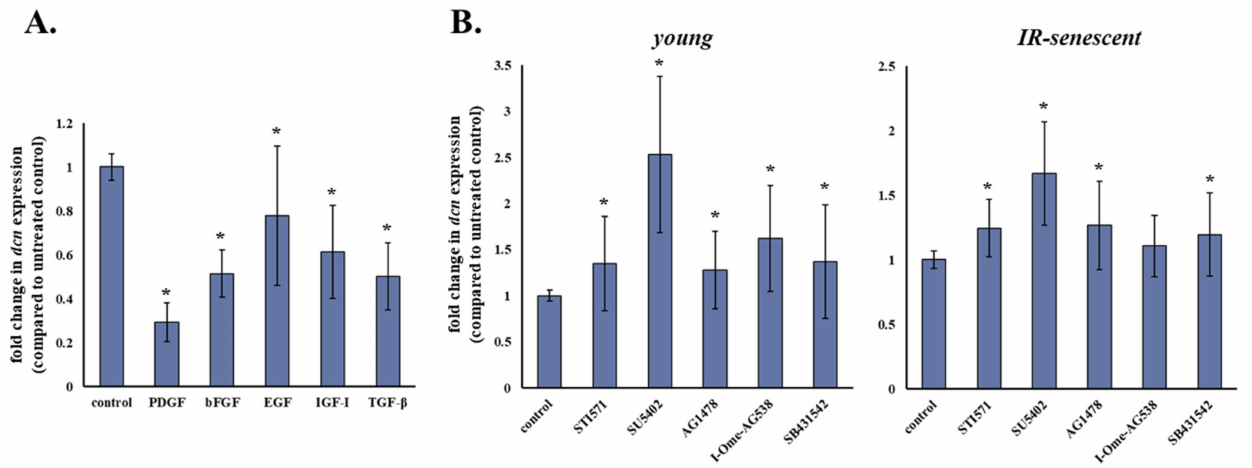
Figure 3. Decorin expression is decreased in human breast stromal fibroblasts as a response to exogenous growth factors. ( A ) Human breast stromal fibroblasts were subjected to starvation by medium change to serum-free DMEM for 24 h and were then treated with PDGF (10 ng/mL), bFGF (10 ng/mL), EGF (100 ng/mL), IGF-I (100 ng/mL) or TGF- β (5 ng/mL) for another 24 h before RNA extraction and RT-qPCR analysis. ( B ) Young and ionizing radiation-induced senescent human breast stromal fibroblasts were incubated for 24 h with the growth factor receptor inhibitors (STI571 for PDGFR (2 µ M); SU5402 for FGFR and VEGFR (20 µ M); AG1478 for EGFR (3 µ M); I-OMe-AG538 for IGFIR (12 µ M); SB431542 for TGF β R1 (10 µ M)). Then, RNA was extracted and decorin (dcn) expression was estimated by real-time PCR after first-strand cDNA synthesis. Glyceraldehyde-3-phosphate dehydrogenase (GAPDH) was used as the reference gene. Ratios of the expression levels of treated cells to those of the untreated control are shown as means ± standard deviations of eight and five independent experiments for ( A , B ), respectively. Asterisks (*) stand for statistically significant differences in comparison to the respective untreated control (Student’s t test, p < 0.05). IR: ionizing